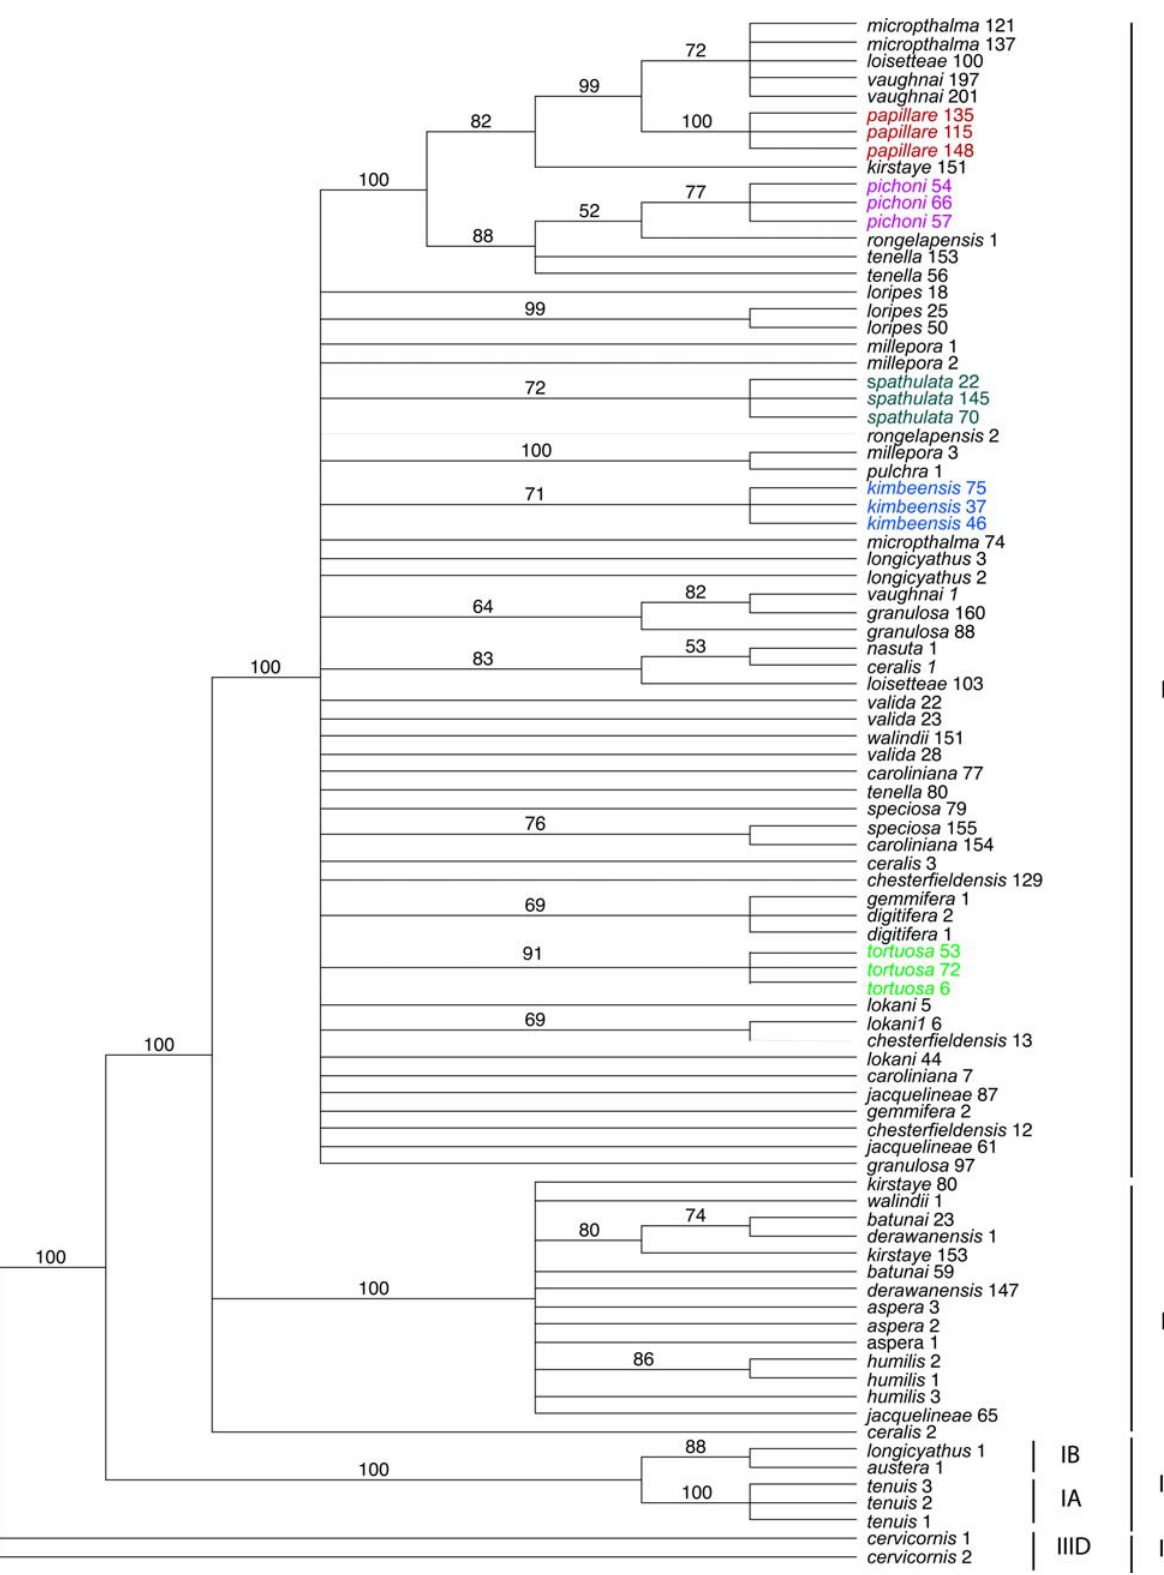
Figure 4. Phylogenetic analysis of mitochondrial sequence data. The figure shows the majority rule ( . 50%) consensus tree obtained in a Bayesian analysis of mitochondrial sequence data for thirty-five Indo-Pacific Acropora species with the Caribbean species Acropora cervicornis defined as outgroup. Bayesian analysis used likelihood settings from best-fit model (HKY + I + G) selected by hLRT in MrModeltest 2.2 [12]: 5 million generations; burn in =20,000. Numbers above branches are posterior probability values supporting the topology shown and clades are labelled according to previous [5,9] analyses. Numbers after species names indicate the coral colonies from which the sequences were obtained. doi:10.1371/journal.pone.0003240.g004 PLoS ONE |